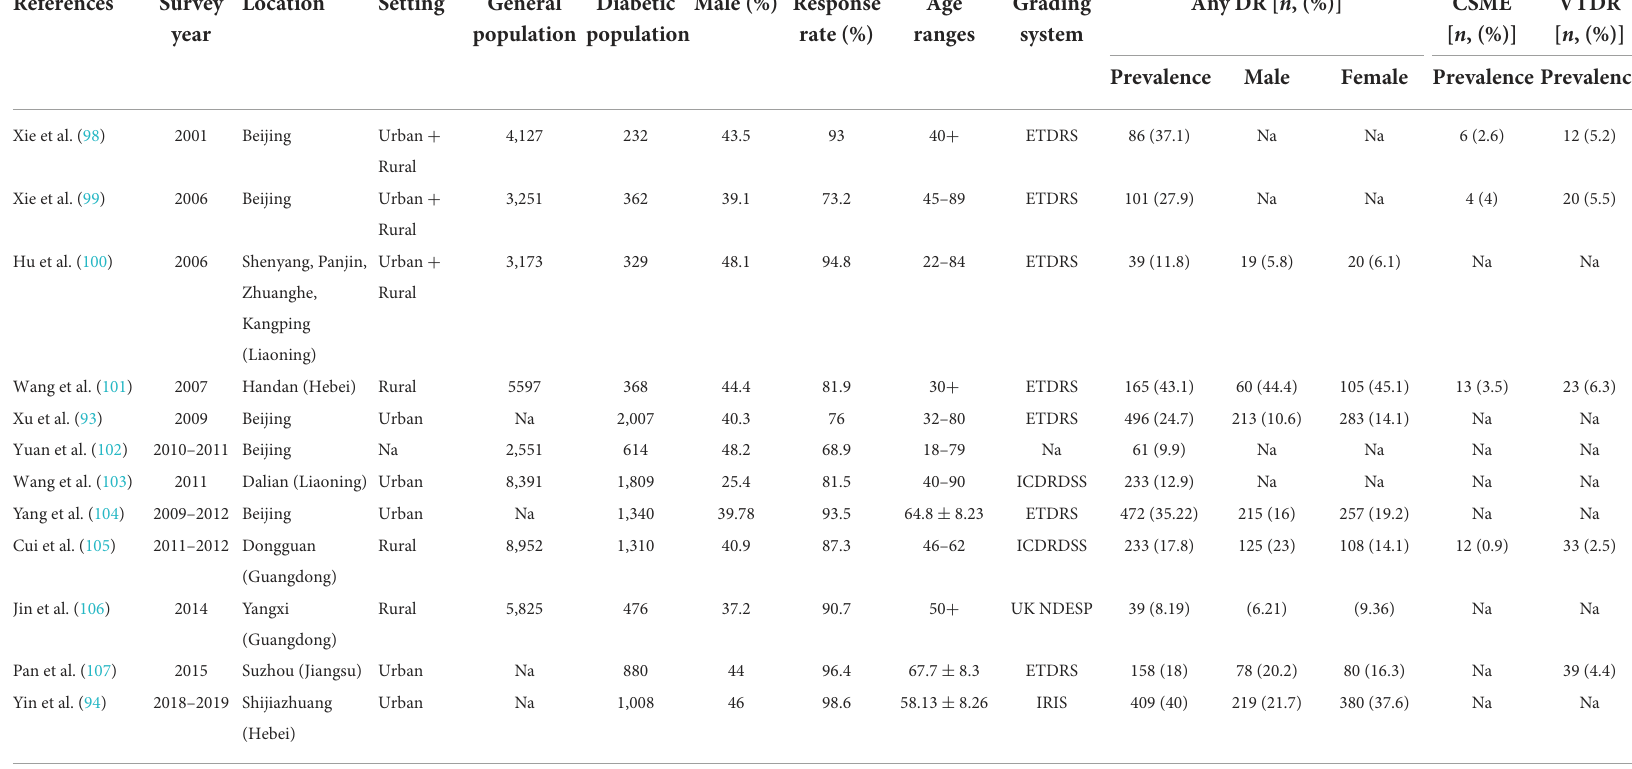
TABLE 3 Detailed characteristics of the main studies on DR prevalence in mainland